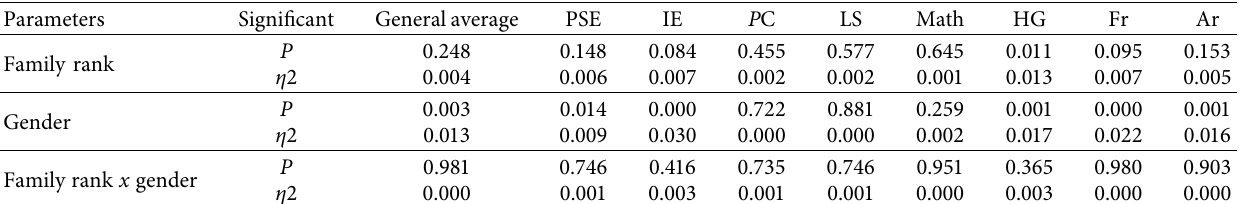
Table 4: Effect of family rank and gender on student’s academic